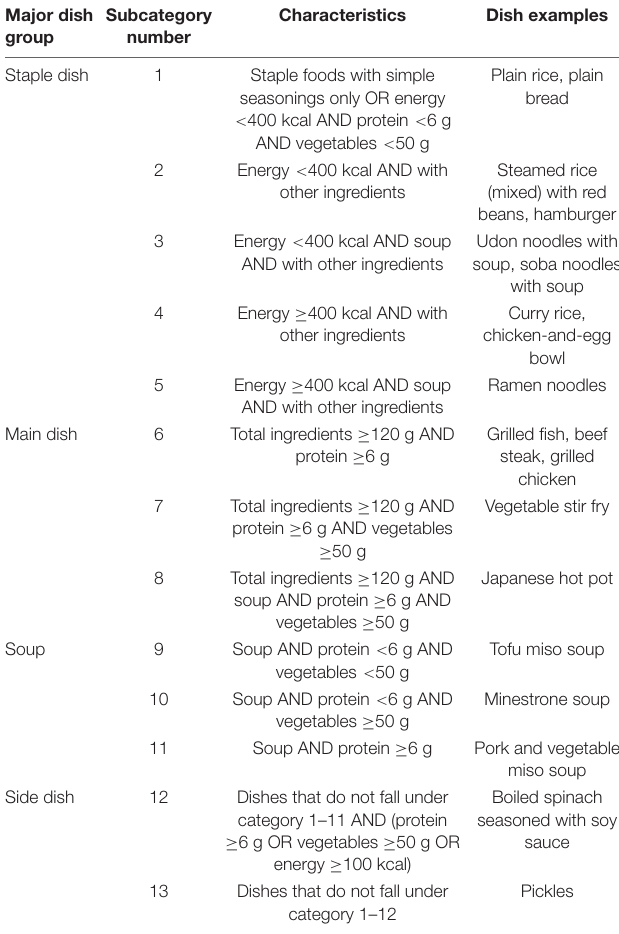
TABLE 1 | category classifications of the Ajinomoto Group Nutrient Profiling System